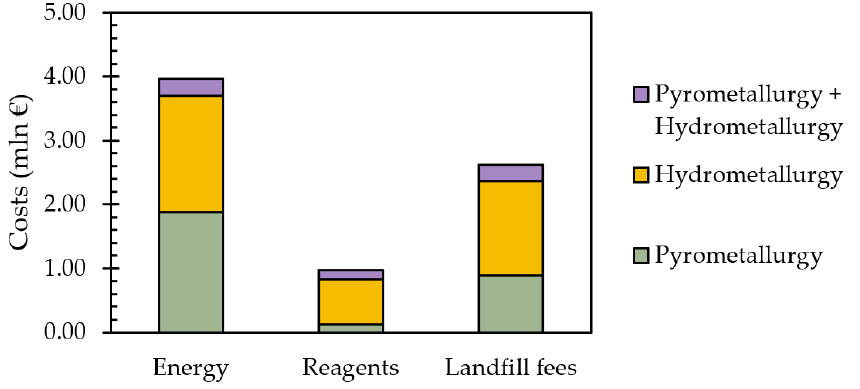
Figure 5. Costs (million €) associated to the material flows deriving from LIBs’ recycling in 2030. The input materials demand has been estimated as 13.3 kt of sodium hydroxide solution (71.5% by pyrometallurgical plants and 28.5% by pyrometallurgical plants with additional hydrometallurgical treatments), 5.3 kt of water (50.9% by pyrometallurgical plants, 13.2% by hydrometallurgical plants, and 35.9% by plants with pyrometallurgical and hydrometallurgical treatments combined), 4.9 kt of sulfuric acid, and 2.5 kt of lime for hydrometallurgical processes.